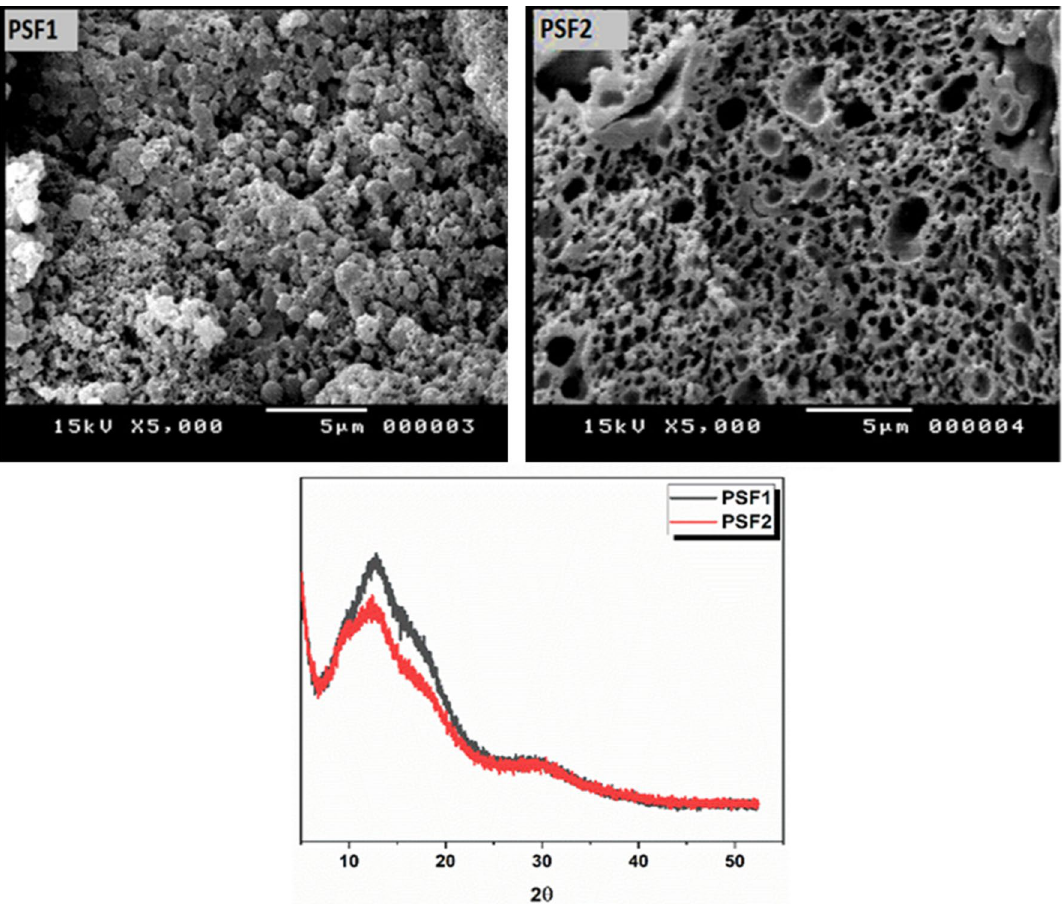
Figure 6. X-RD and SEM images at magnification (X = 5000) of PSF1,